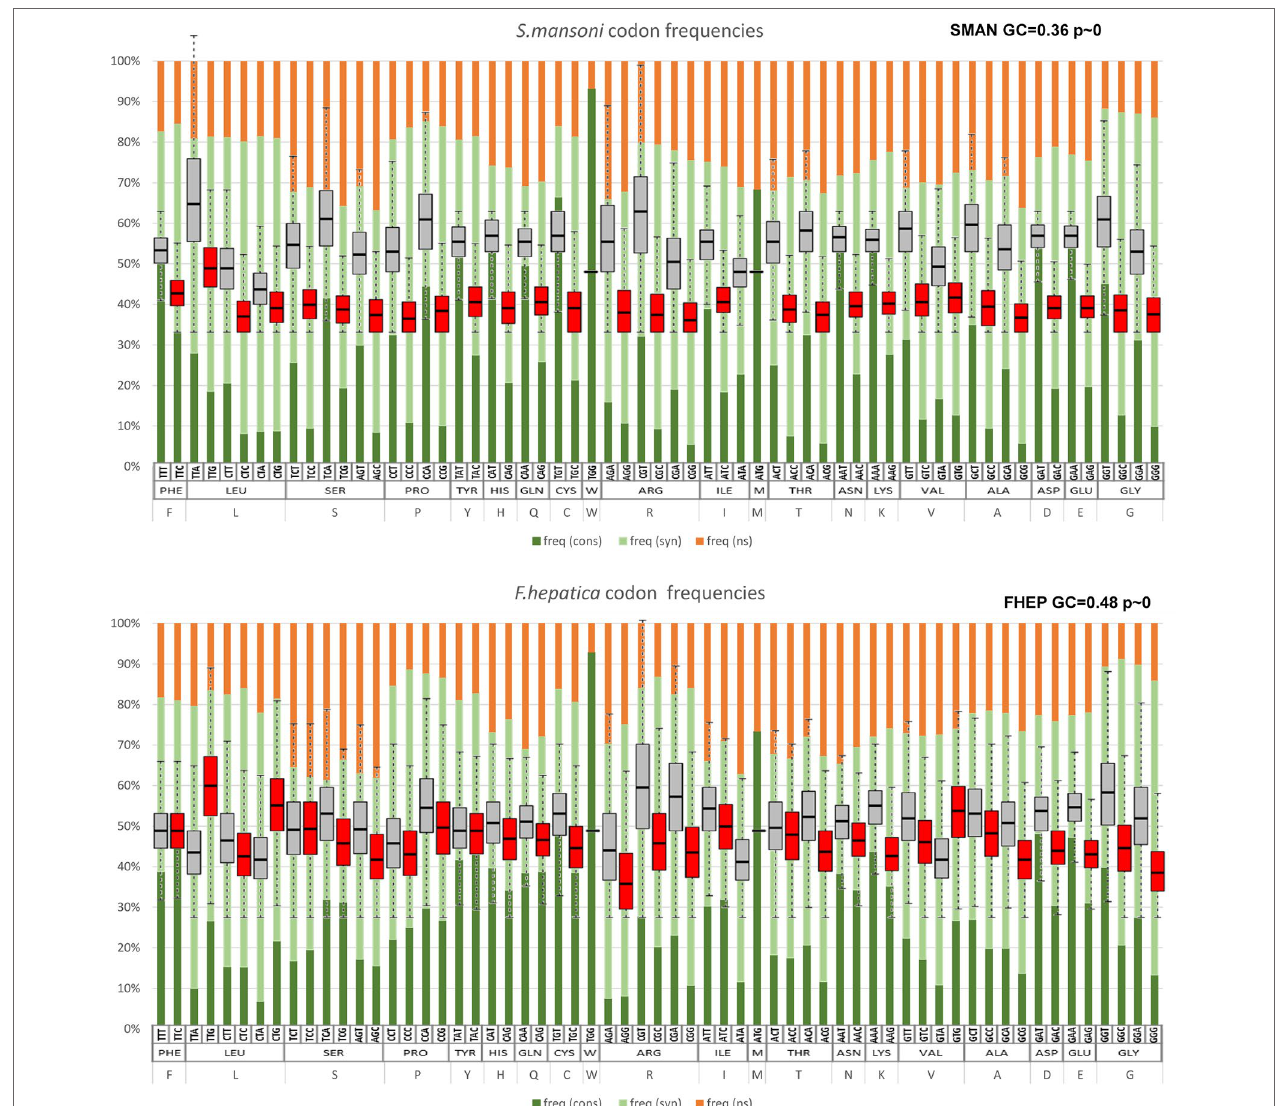
FIGURE 8 | Codon changes between S. mansoni and F. hepatica. The substitution state for each codon in pairwise alignments is represented in bars, indicating conserved codons (dark green), synonymous substitutions (pale green), and non-synonymous changes (orange). Note the enrichment of synonymous changes in GC3-poor codons in S. mansoni (top) in comparison with F. hepatica (bottom). For comparison, the figure is overlaid with the codon frequencies of Figure 3